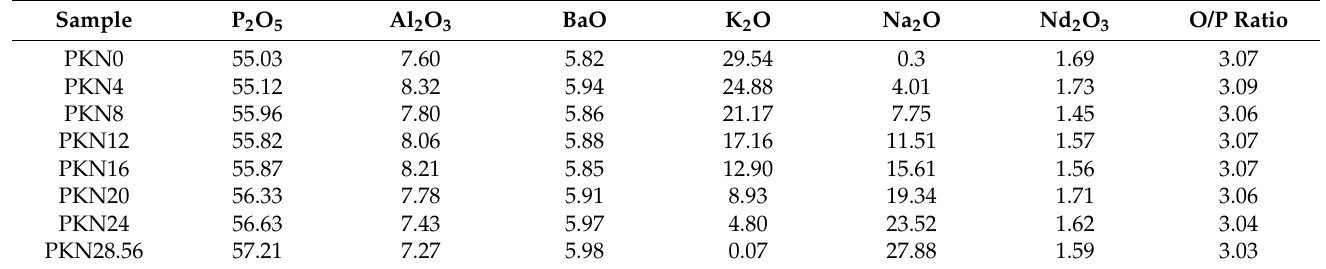
Table 1. Chemical composition (mol%) of PKNi glasses with different Na/K ratios measured by ICP.